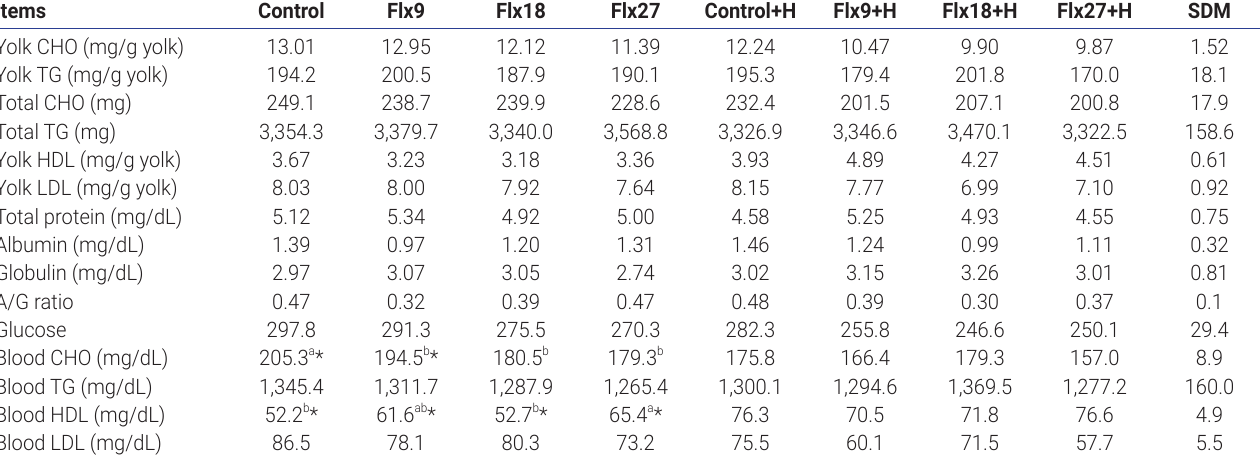
Table 6. Egg lipid components and blood biochemistry of laying hen were fed test diets with different levels of flaxseed with and without herbal medicines for nine weeks Items